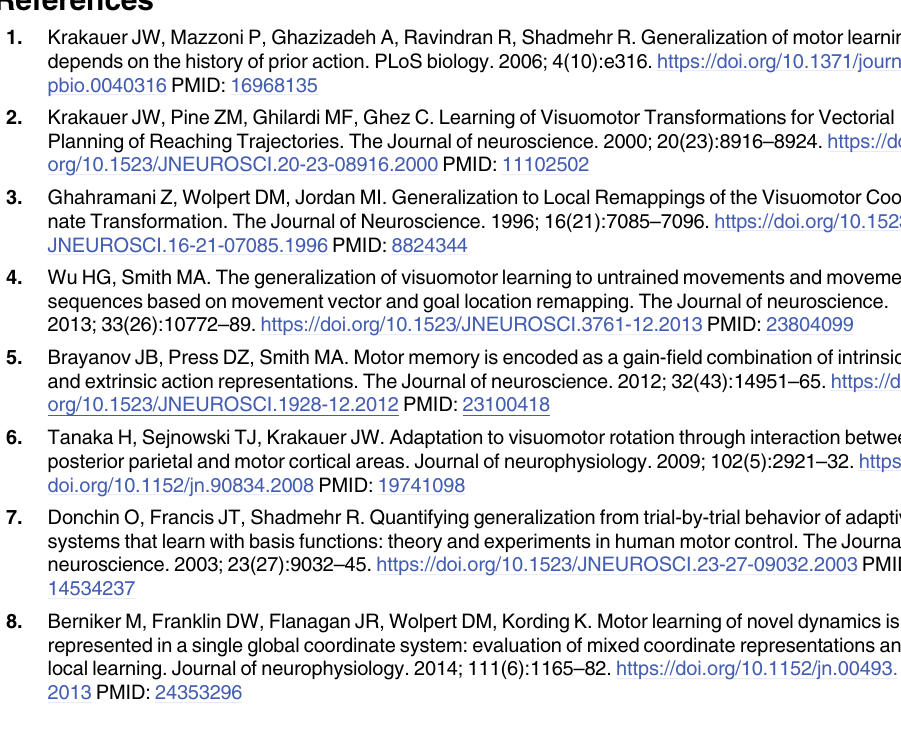
followed a rest break (these trial were excluded from analysis), ‘Field’ indicating the trial type (0 = Null, 1 = Force field, 2 = Channel), ‘Adaptation’ indicating the adaptation measure for channel trials, and ‘KinematicError’ indicating the max perpendicular error (MPE) for non- channel trials. S2 Data. Data information. A Matlab script containing details about the data